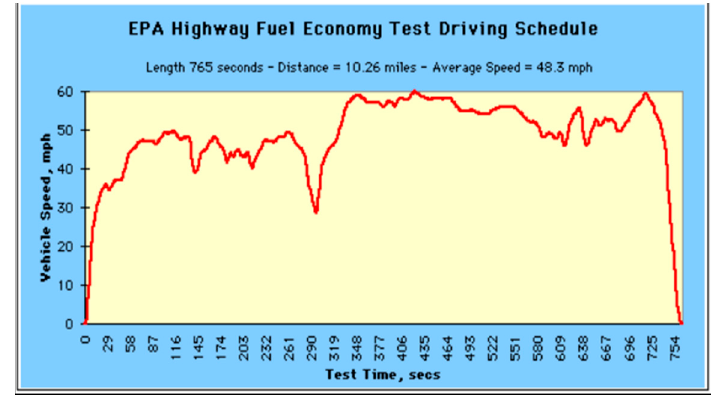
Figure 16. HWFET drive cycle.